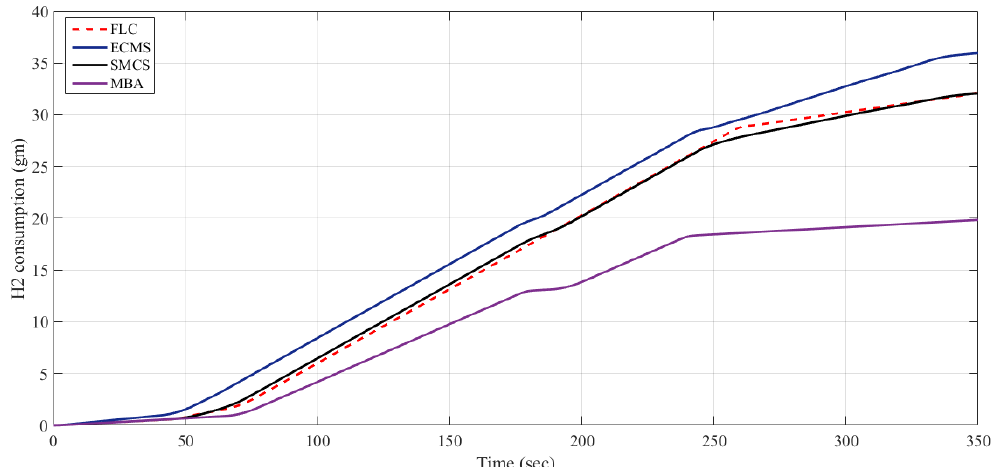
Figure 10. H 2 consumption variation for different considered methods.